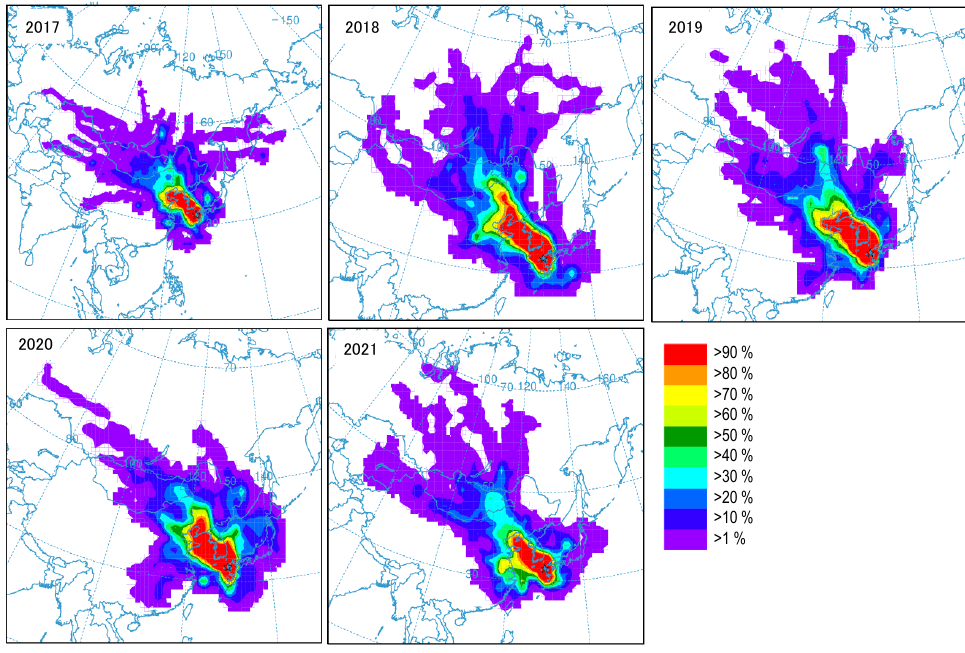
Figure 2. Frequency of residence of back trajectories in a grid cell in winter calculated by HYSPLIT Model of the National Oceanic and Atmospheric Administration, USA. The analysis period was set from 30 December – 3 February in each year.